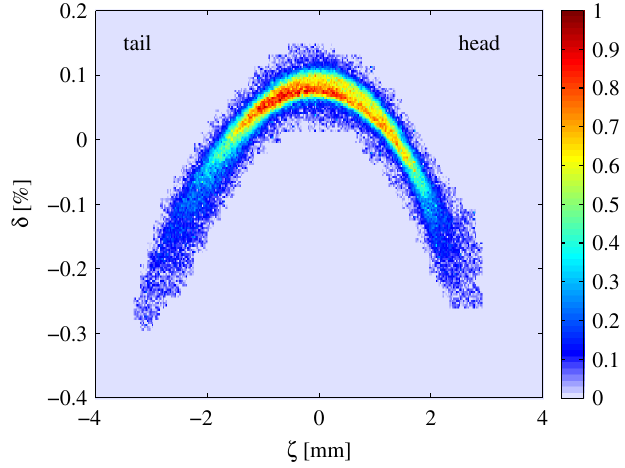
FIG. 7. (Color) Single-shot measurement of the particle density distribution of an uncompressed bunch in longitudinal phase space ð (cid:2); (cid:9) Þ ( E ¼ 650 MeV , Q ¼ 1 nC ). The bunch compressor magnets were switched off.